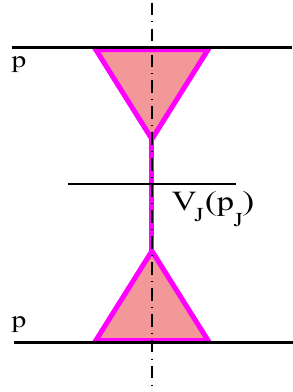
Fig. 1 Schematic view for the general RFT diagram for inclusive jet production in pp collisions: the projectile and target “triangles” consist of fanlike enhanced Pomeron graphs; V J ( p J ) is the parton J emission vertex from a cut Pomeron. The cut plane is shown by the vertical dotted-dashed